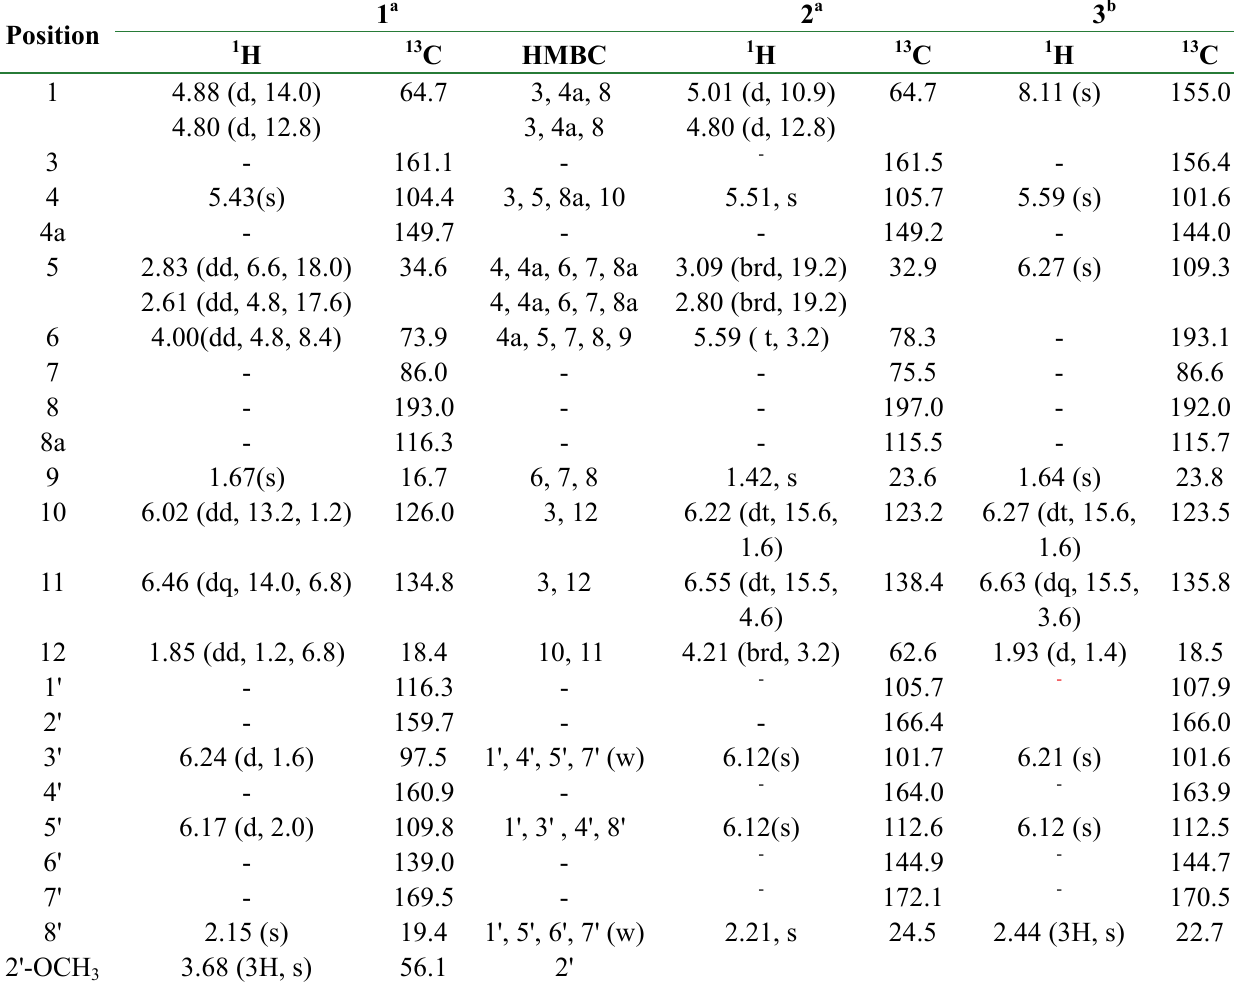
Table 1. NMR data of compounds 1~3